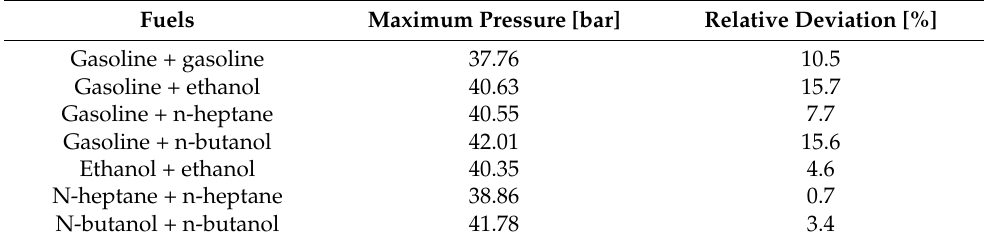
In three cases, the deviation of the relative maximum pressure values exceeded 10%, however the quality of the results was considered to be sufficient for further